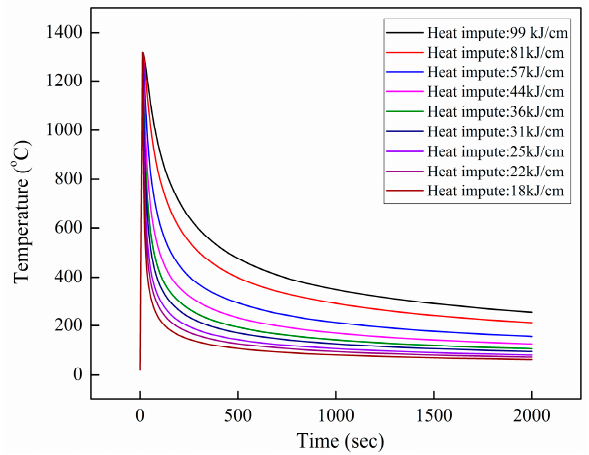
Figure 2. The curve of thermal cycle of different heat input.